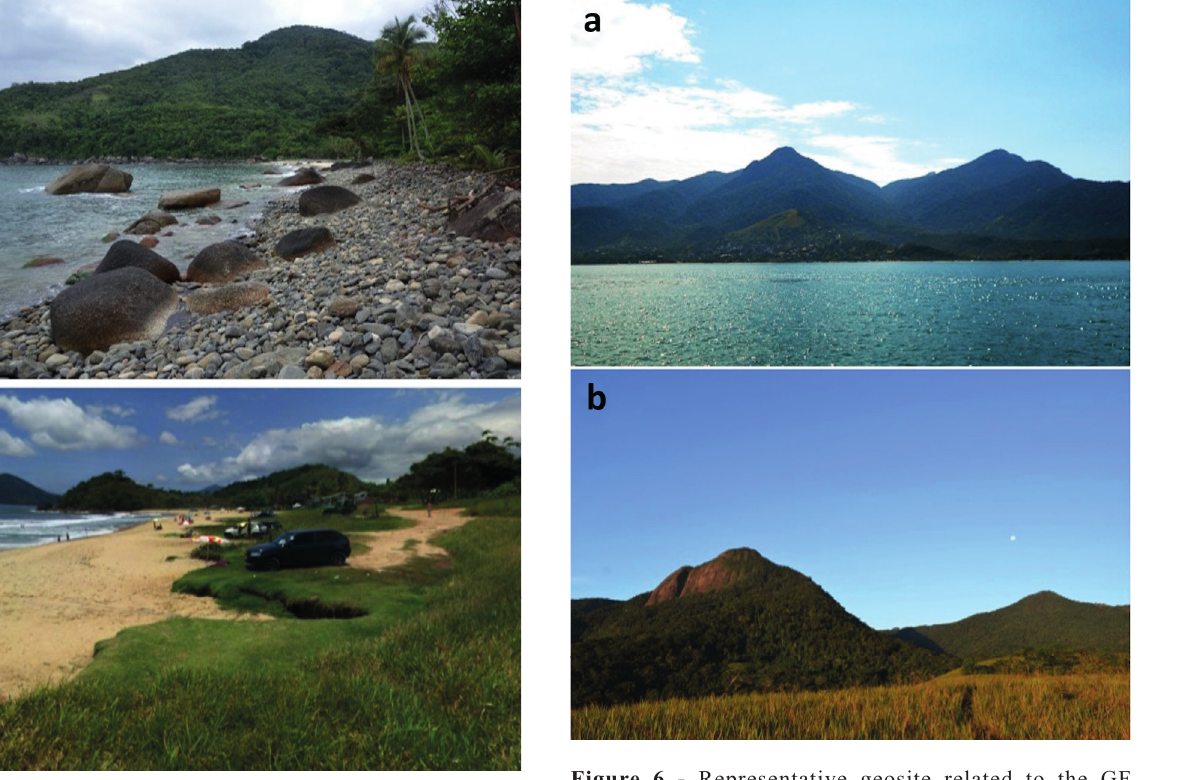
Figure 5 - representative geosites related to the GF Quaternary Evolution. a ) Geosite “Storm-beach sedimentation of Enchovas Beach”. An exceptional example of this type of coastal dynamics presenting linear, zoned areas composed of heavy minerals and centimeter-size pebbles deposits; b ) Geosite “Pleistocene terraces of Vermelha do Norte Beach”. Marine terrace that crops out next to a modern beach, with tectonic infl uence and which acted as a sandy barrier during holocene marine transgression. Photo: Google Earth.